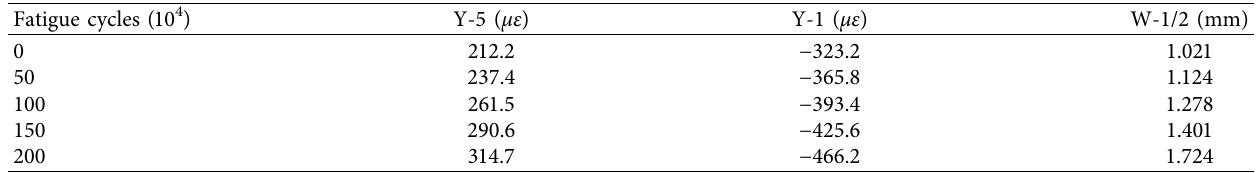
Table 13: The relation between deflections and strain and fatigue loading times for carbon-fiber-reinforced plate (corroded by car- bonization) under the 200kN load.